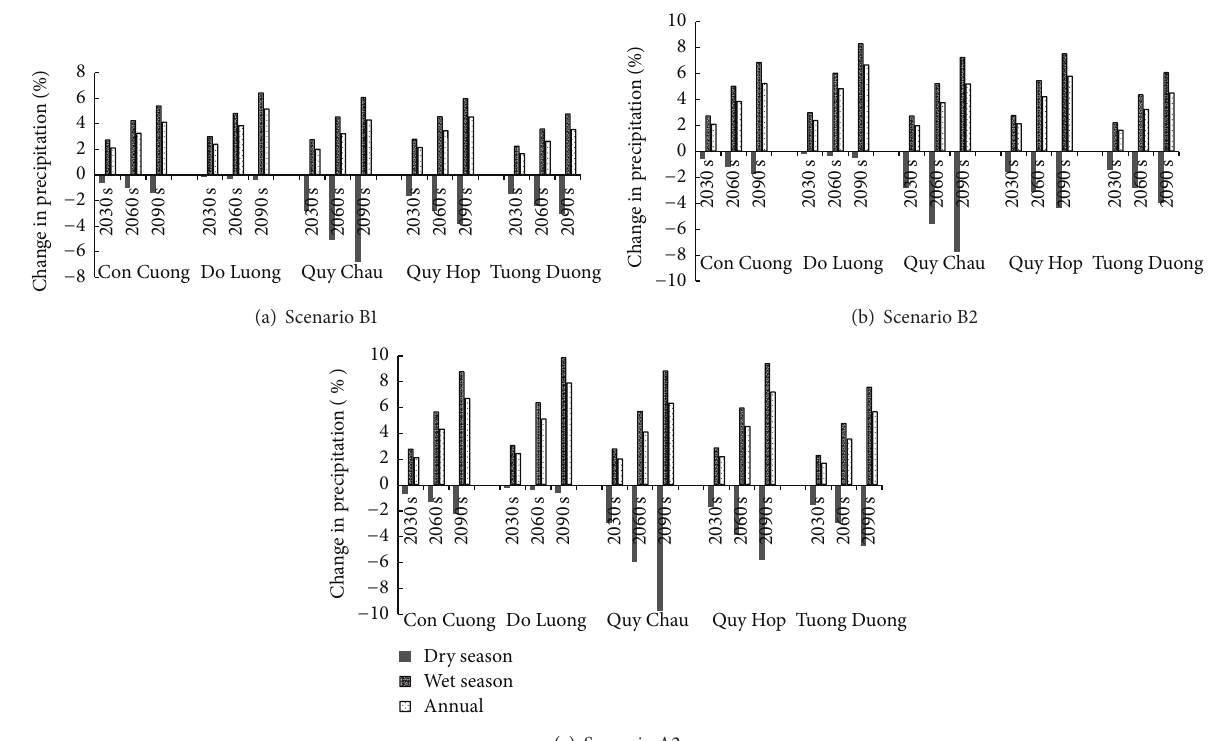
Figure 8: Relative change in mean seasonal and mean annual precipitation of five stations for three future periods under three different scenarios.